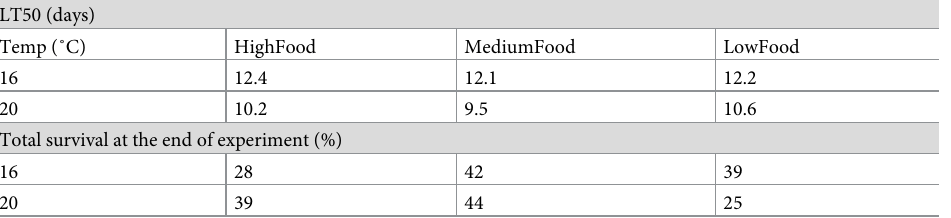
Table 2. Lethal time for 50% (LT 50 , days) Solea solea larvae reared at two temperatures with different feeding fre- quencies and total survival at the end of the